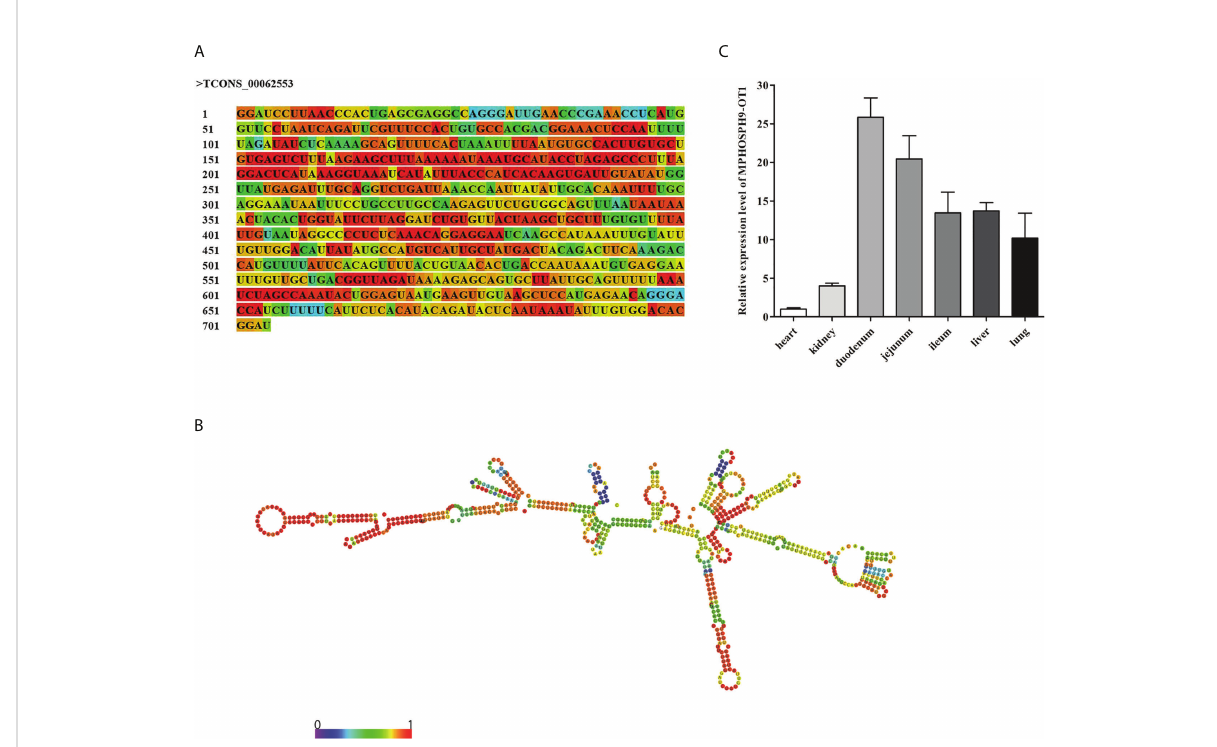
FIGURE 4 Sequence, structure, and distribution of novel lncRNA MPHOSPH9-OT1. (A) The sequence of MPHOSPH9-OT1. The colors of the nucleotides corresponding to the colors in (B) indicate the stability of the local secondary structure. (B) The predicted optimal secondary structure of MPHOSPH9-OT1 with minimum free energy of -175.10 kcal/mol via RNAfold WebServer (http://rna.tbi.univie.ac.at/cgi-bin/RNAWebSuite/ RNAfold.cgi). The color from purple to red represents the base-pair probabilities from 0 to 1. A higher probability indicates a stabler base- pairing. (C) Distribution and expression of MPHOSPH9-OT1 in porcine organs. LncRNA level of MPHOSPH9-OT1 in each organ was detected using qRT-PCR and quanti fi ed by the 2 - DD Ct method normalized to GAPDH. The y-axis shows the relative expression of MPHOSPH9-OT1 in each organ compared to that in the heart which was set to